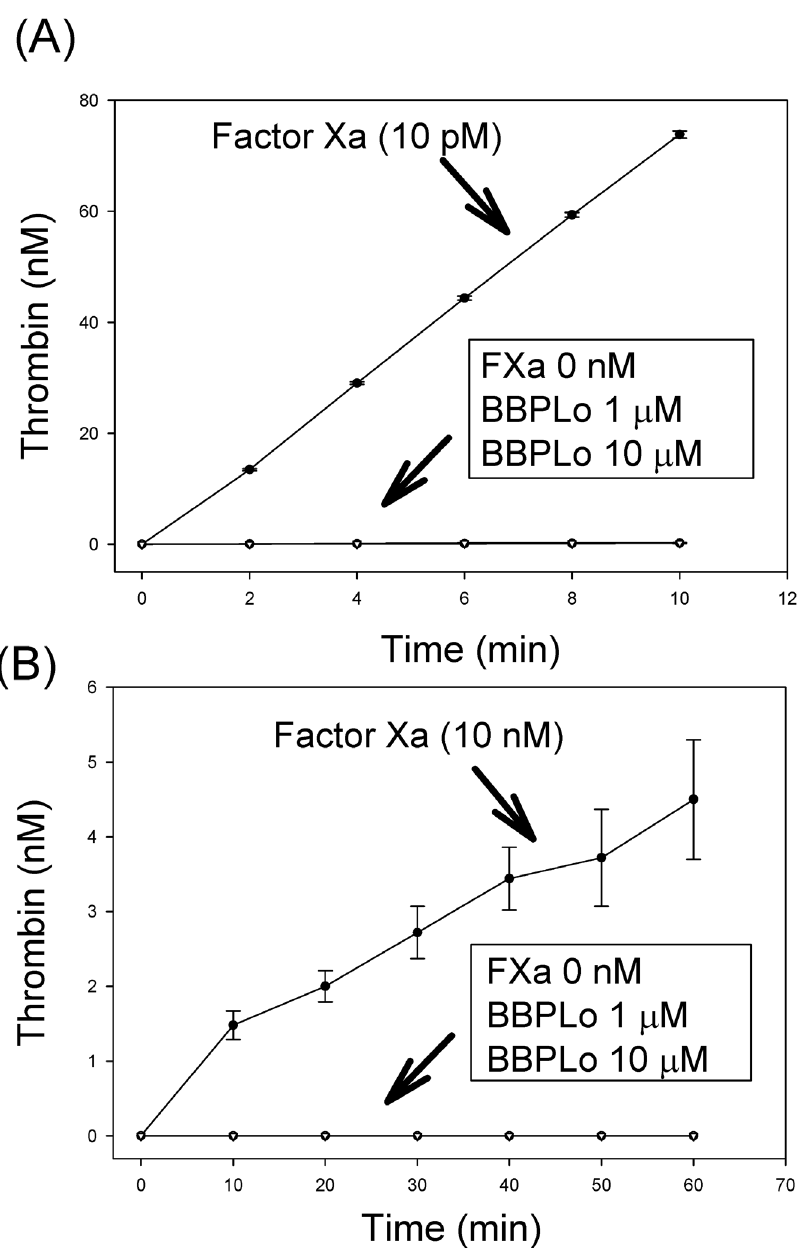
Figure 10. BBPLo does not substitute FXa in the prothrombinase complex (a), nor directly activates FX (b). In both panels the points represent the mean of three replicate measurements and error bars represent the standard error of the mean. (a) Prothrombin (1.4 m M) activation by FXa (10 pM) or BBPLo (1 m M) or (10 m M) in the presence of FVa (1 nM) and 10 m M PC/PS vesicles (prothrombinase complex) as described in the Methods Section. (b) Activation of prothrombin (1.4 m M) by FXa (10 nM) or BBPLo (1 m M and 10 m M) in the absence of FVa and PC/PS vesicles was also evaluated. Thrombin formation was detected using the specific substrate S-2238 (312.5 m M) and the amount of enzyme formed was calculated using a standard